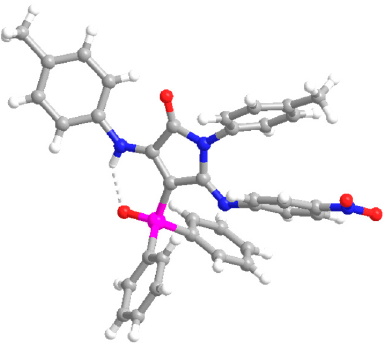
Figure 3. X-ray structure of functionalized γ -lactam 13 (H, white; C, grey, O, red, N, blue, P, pink).